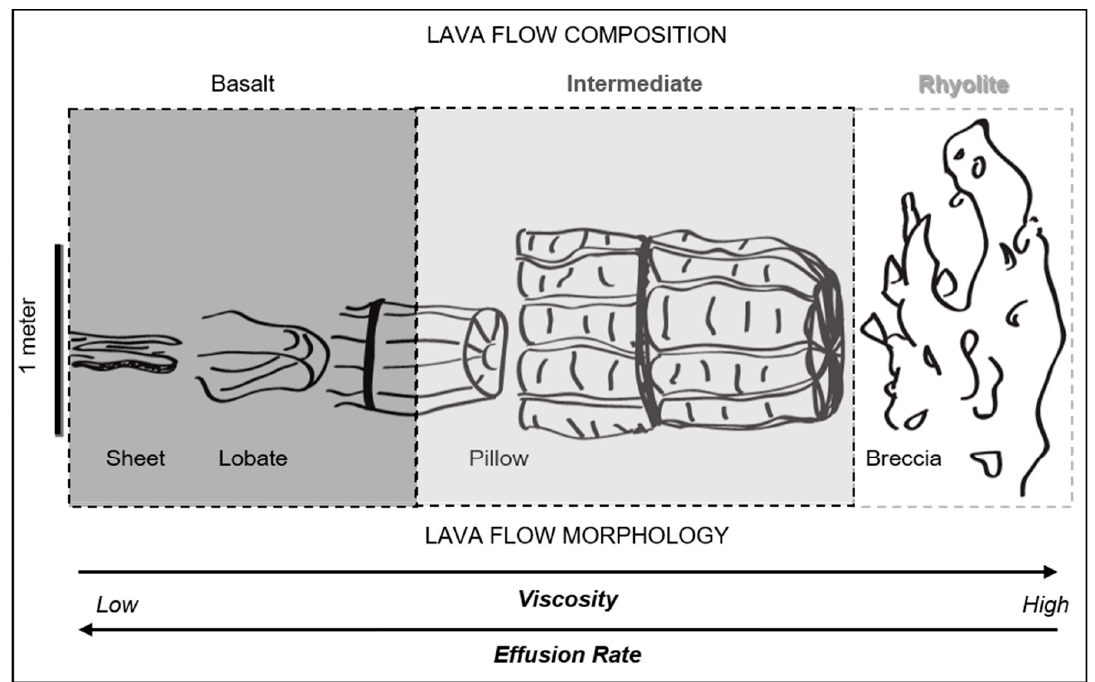
Figure 14. Changes in lava flow geomorphology and inferred emplacement processes with lava composition. Low-viscosity basaltic lava may erupt as sheet, lobate, or pillow morphologies depending on lava effusion rate. Lava flows with intermediate composition will emplace as pillows with diameters > 1 m. The surfaces of these pillows will have striations ~10 cm deep, compared to basaltic pillows with striations ~1 cm deep. Rhyolitic lava flows will form jagged branches or may brecciate upon eruption.